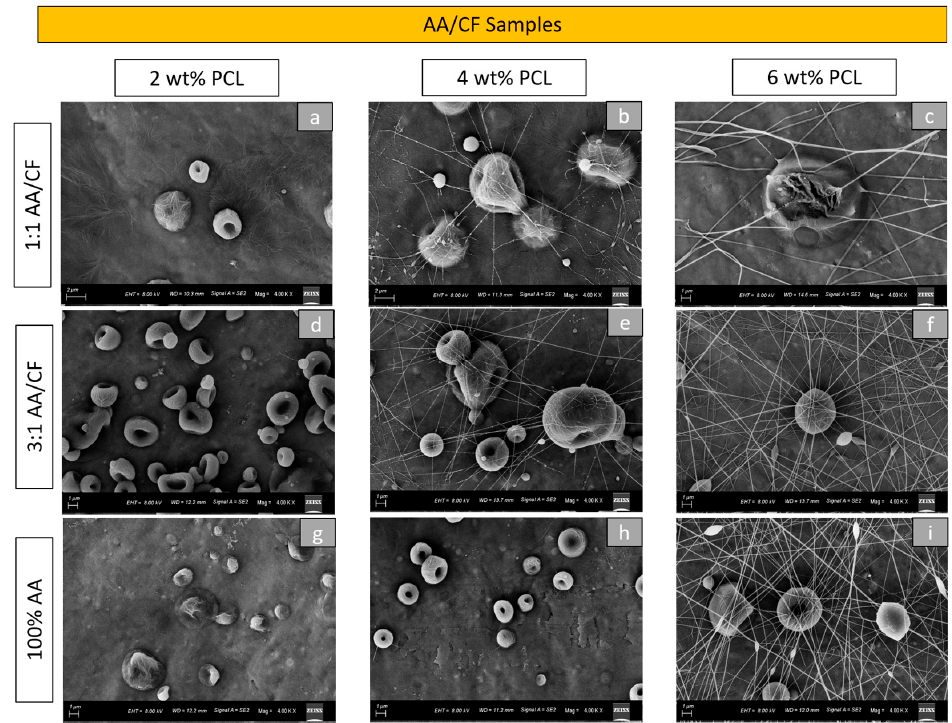
Figure 2. Morphological aspect of the electrosprayed particles produced under SEM (4.00 kx